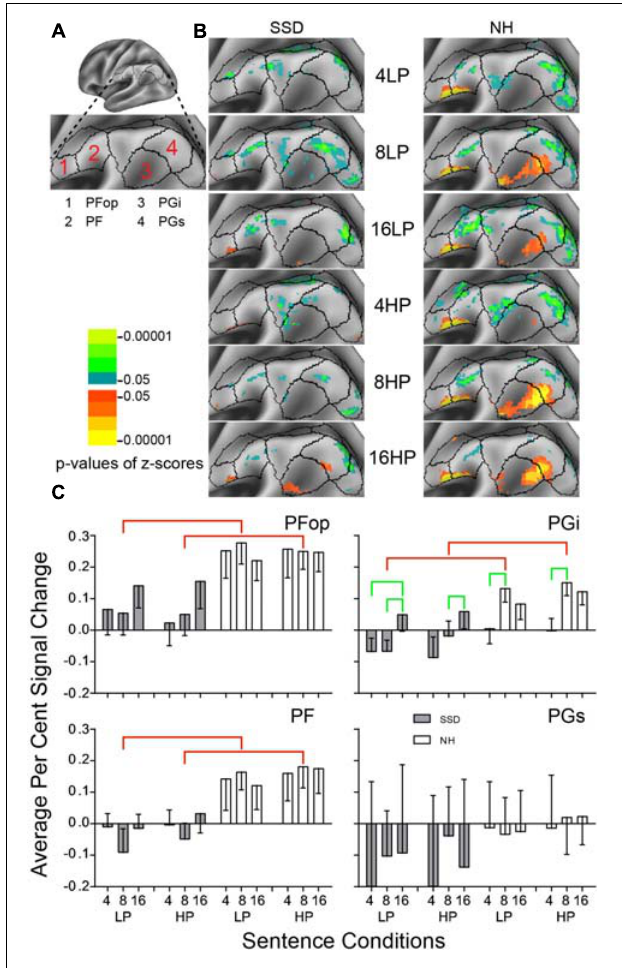
FIGURE 7 | Results from four parcels in the LH Inferior Parietal Cortex (IPC) region. (A) Lateral view of a partially inflated hemisphere. (B) Enlarged views of parcels show clusters with significant mean z-scores of p < 0.05 for positive BOLD (colored red-orange to bright yellow) and negative BOLD scaled blue to light green. (C) PFop, PF, and PGi had significant group effects marked with red brackets. PGi had significant intelligibility effects marked with green